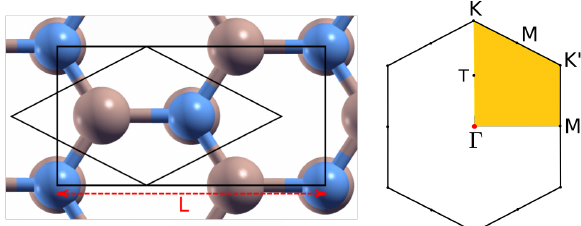
Figure 1: [ Color online ] Structure of strained hexagonal Boron Nitride along the B-N bonding, obtained by stretching the equilibrium orthorhombic cell. Pseudo- hexagonal cell is shown on the left, and the corresponding Brillouin zone is shown on the